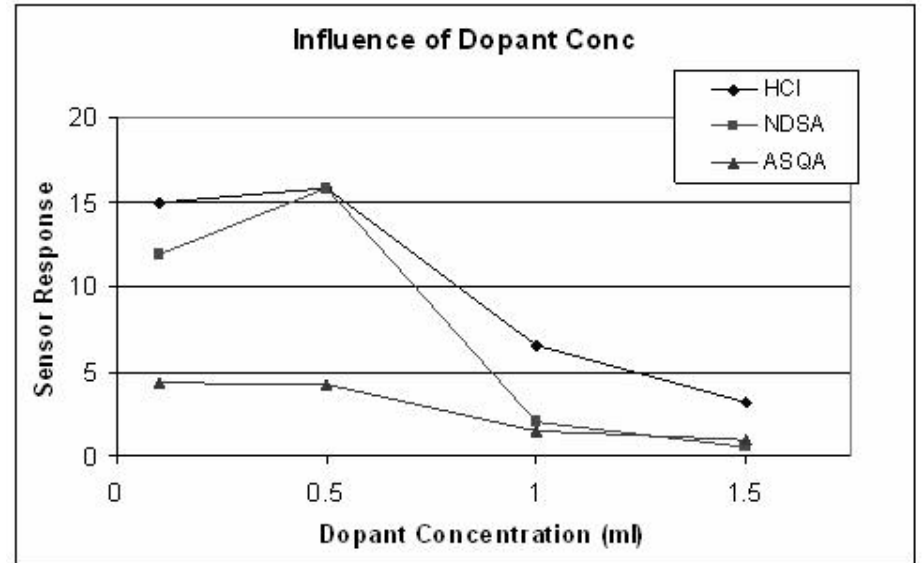
Figure 17. Influence of dopant concentration on sensor